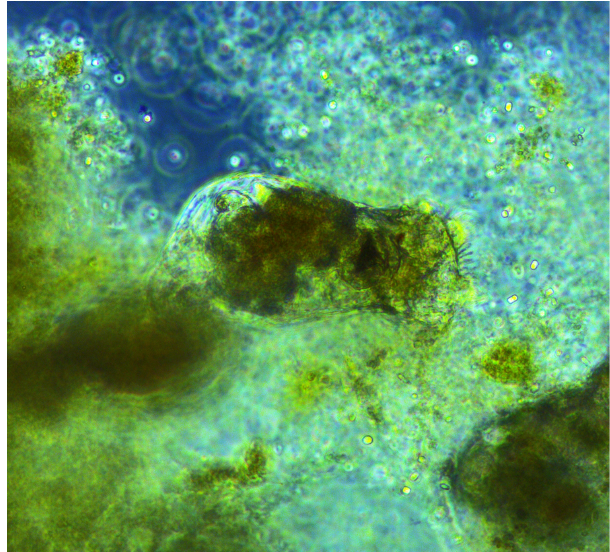
Fig. 10. Image of rotifer associated with (and actively feeding on) an aggregate during the